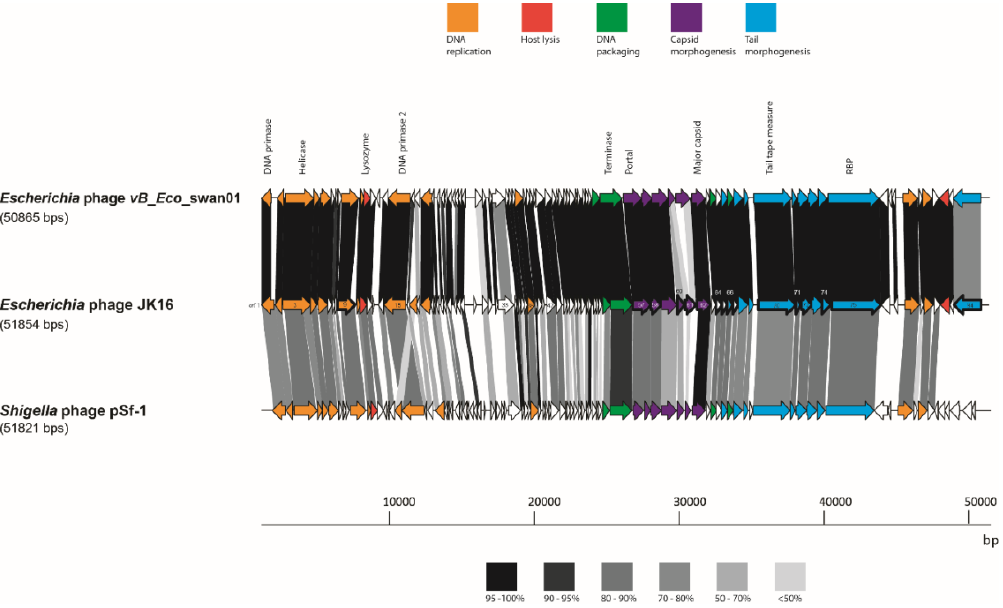
Figure 4 . Genome maps of JK16 phage and its close relatives, vB_Eco_swan01 and pSf-1. The putative functional regions are indicated with the colors described above. ORF sharing amino acid identity are linked by grey shading. The degree of sequence sharing is described by the shading scale in the bottom of the figure. The ORFs of JK16 phage that have been identified as structural components using ESI-MS/MS are outlined with a thick line.